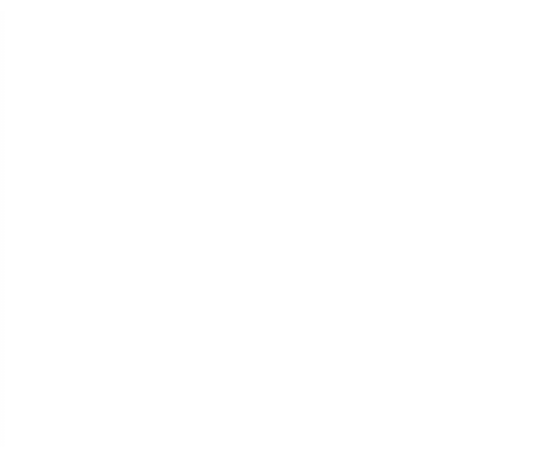
Figure 7. Dubins path (RLR) when d < R , where the aircraft first turns right, then left, and lastly right to complete the Dubins